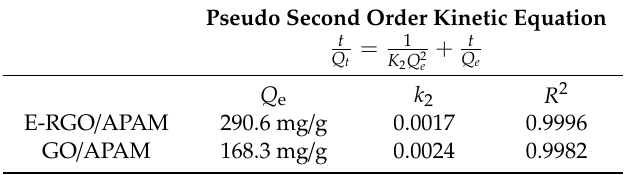
Figure 5. ( a ) Influence of adsorption time on the adsorption capacity of GO / APAM and E-RGO / APAM; ( b ) pseudo second order kinetic equation fitting of Pb(II) adsorption by GO / APAM and E-RGO / APAM; ( c ) Langmuir and Freundlich adsorption model of E-RGO / APAM (conditions: pH = 5, T = 30 ◦ C).